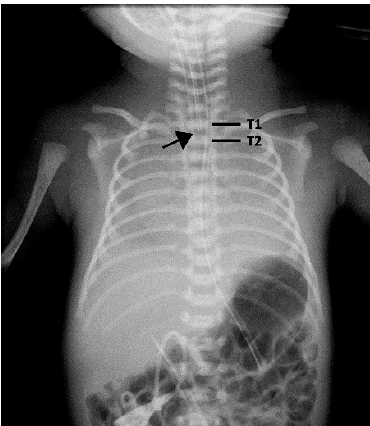
Figure 1. Black arrow pointing to the optimal ETT depth. (The tip of the tube is located in the mid- trachea adjacent to the first or second thoracic vertebra as recommended by the 7th Neonatal Re- suscitation